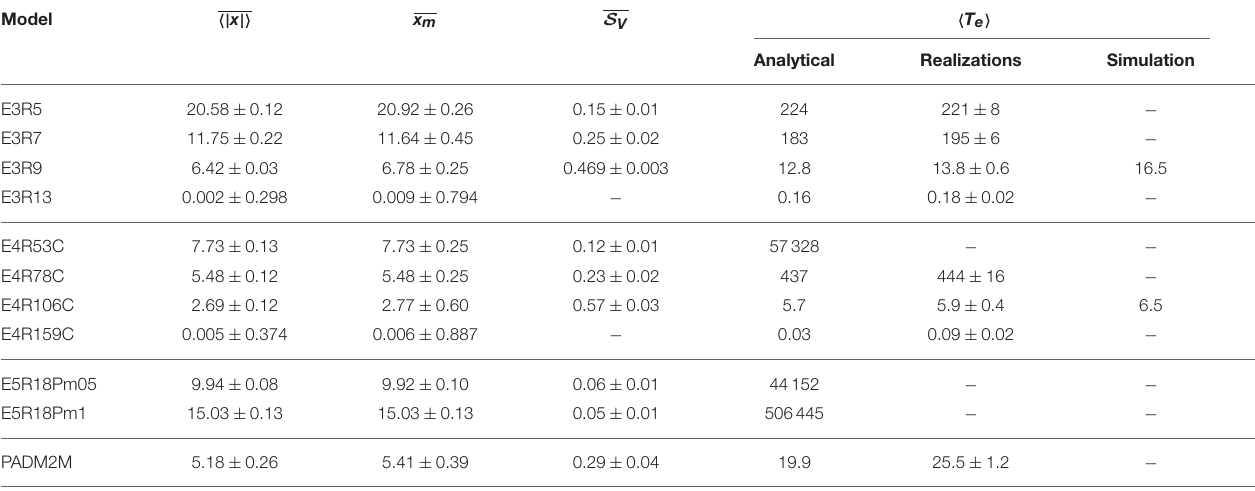
TABLE 3 | Relevant statistical properties of the axial dipole moment inferred from numerical realizations of the stochastic model for all the cases explored. Model h| x |i h T e i